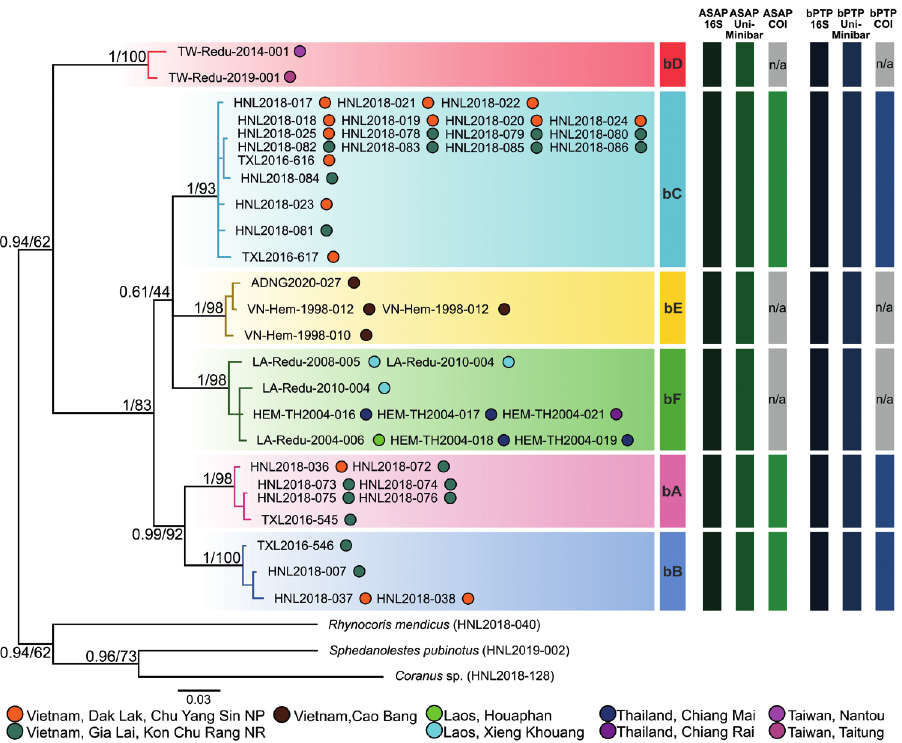
Figure 12. Bayesian inference phylogenetic tree based on the concatenated 16S + Uni dataset (661 bp) of Biasticus species collected from Vietnam and its surrounding areas. Posterior probability values and bootstrap values (in %) were given beside the basal nodes. The tips are labeled with the specimen IDs. The circles after specimen IDs showed the collecting